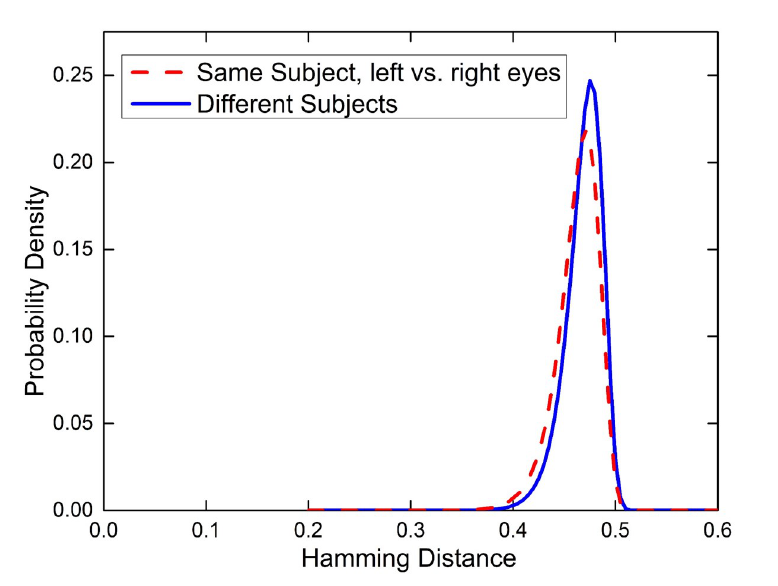
Figure 8. The distribution of iris biometric scores between left and right eyes of the same subject is statistically indistinguishable from the distribution of scores from left and right eyes of different subjects. The results were obtained using the CAS-SIAT-Iris dataset, and are consistent with